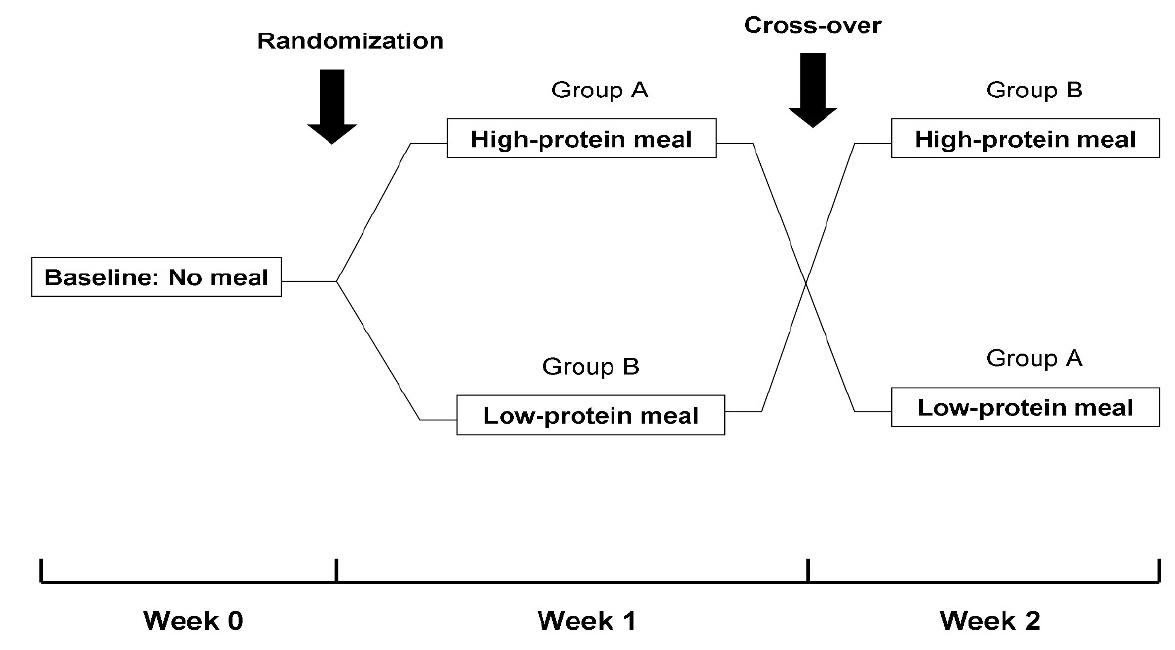
Figure 1. Flowchart of study